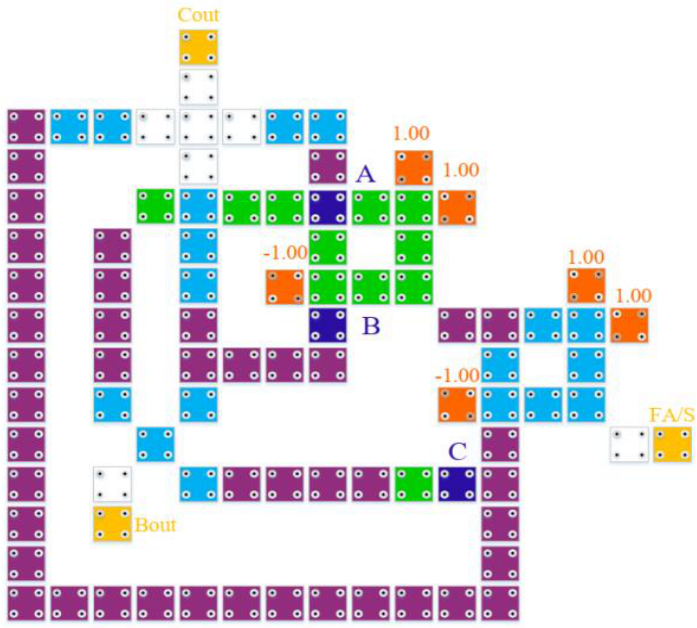
Figure 11. Full Adder/Full Subtractor circuit [17]-b.